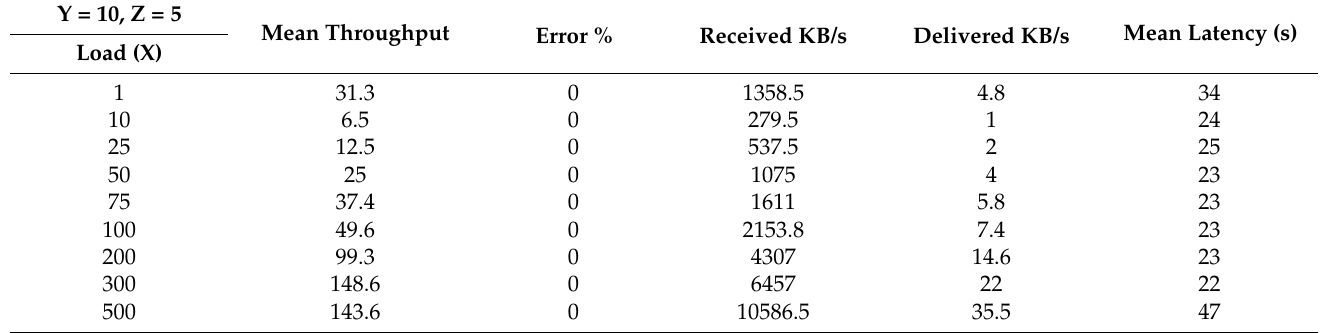
Table 13. Scalability testing results with Y = 10, Z = 5, and variable loads (X).